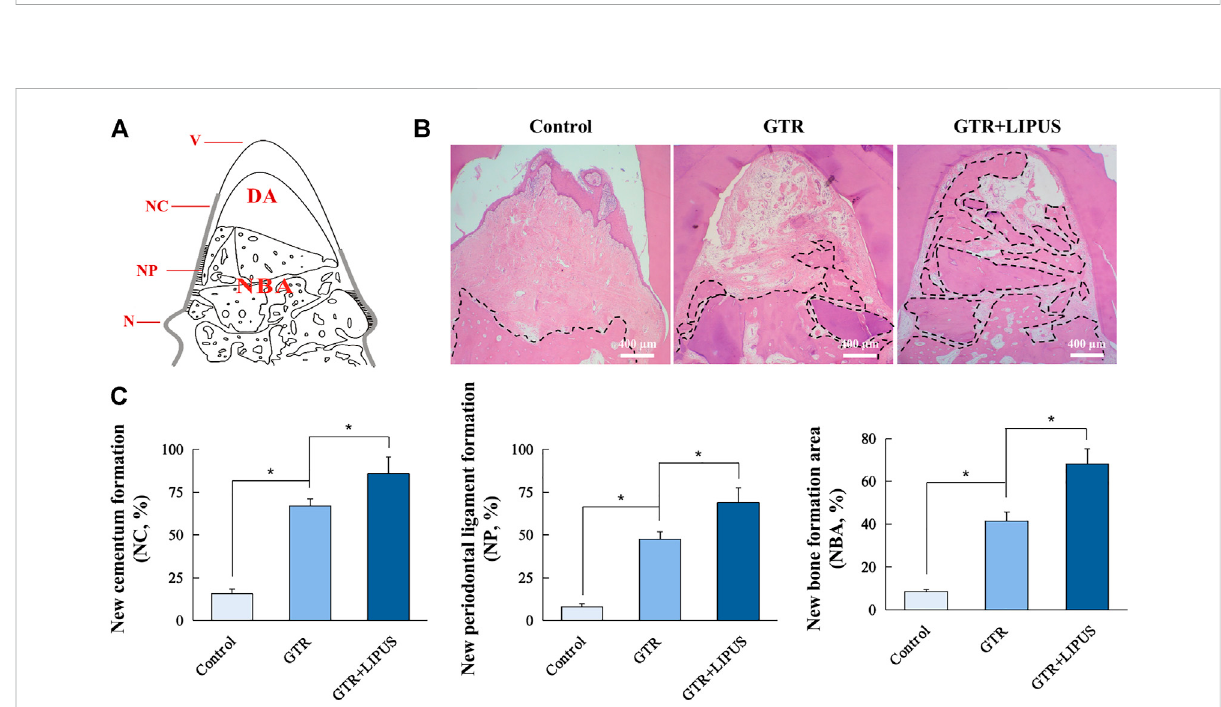
FIGURE 3 Histological and histomorphometric analyses. (A) Schematic illustration of histomorphometric measurements. N: notch; V: vertex of furcation; NC: new cementum; NC% = NC/NV×100%; NP: new periodontal ligament; NP% = NP/NV×100%; NBA: new bone area; DA: defect area; NBA% = NBA/DA×100%. (B) Representative H&E staining of the furcation area. The dotted lines indicate a new bone formation area. Scale bar, 400 μ m. (C) Quantitative analysis of new cementum formation, periodontal ligament formation, and bone formation areas. Data are presented as mean ± SD, * p <